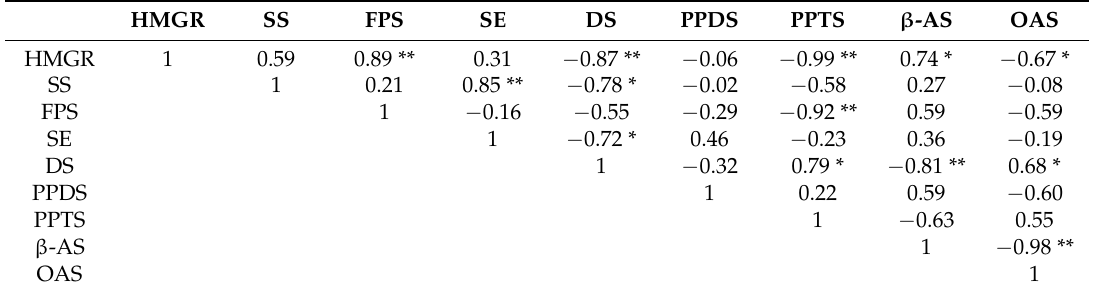
Table 5. Correlation analysis of gene expression in roots at different growth times.